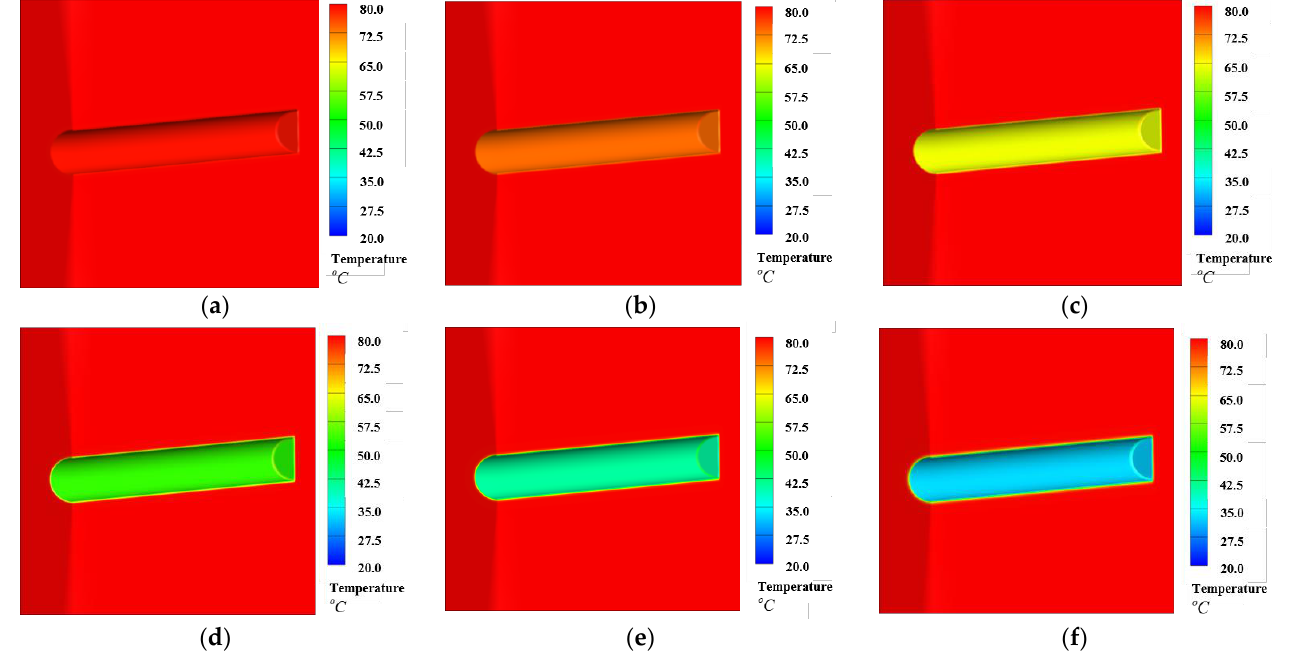
Figure 7. Temperature distribution at t = 0~24 h in the tunnel. ( a ) t = 0 h; ( b ) t = 1 h; ( c ) t = 3 h; ( d ) t = 6 h; ( e ) t = 12 h; ( f ) t = 24 h. ( d ) t = 6 h; ( e ) t = 12 h; ( f ) t = 24